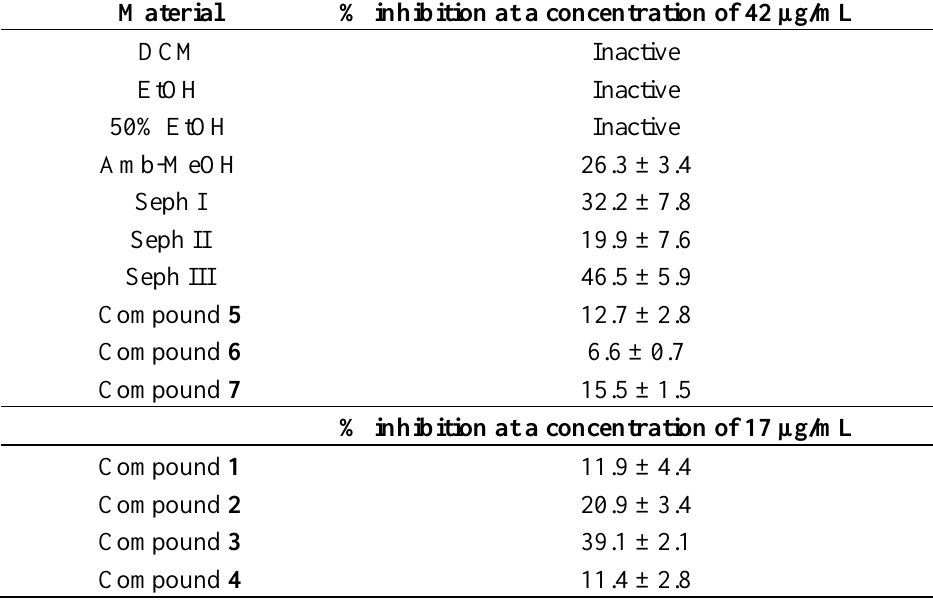
Table 3. Xanthine oxidase inhibitory activity of extracts, fractions and compounds from Aronia